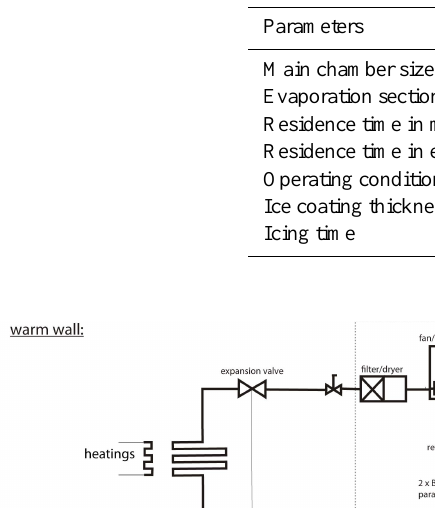
Table 1. Summary of PINC and ZINC characteristics